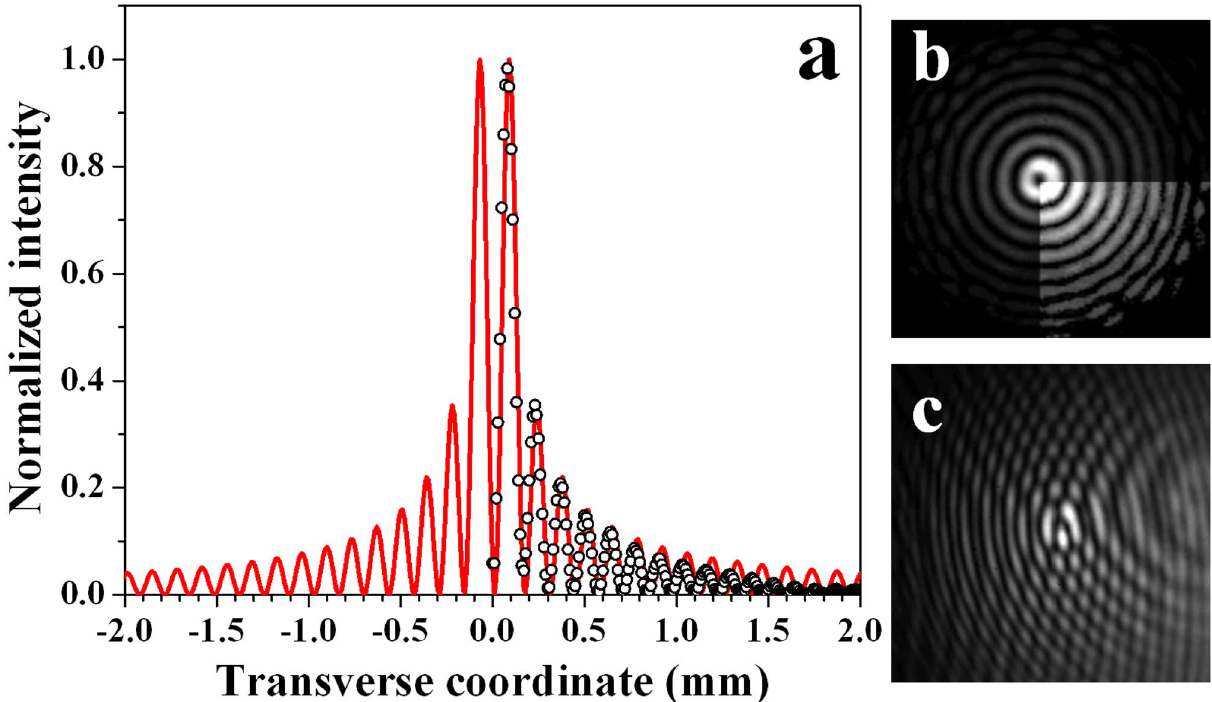
Figure 7. (a) Radial intensity profile of the first-order Gauss-Bessel beam (hollow circles) generated by annihilating 20 from the total 21 OVs ( r 0 /ω 0 = 15 in the plane of the lens) and numerical fit (red solid curve). Power density distribution of this GBB (b) for the same r 0 /ω 0 and interference pattern (c) obtained by overlapping it with an offset spherical wave. The data are recorded 15 cm (4 z R ) behind the focus of the